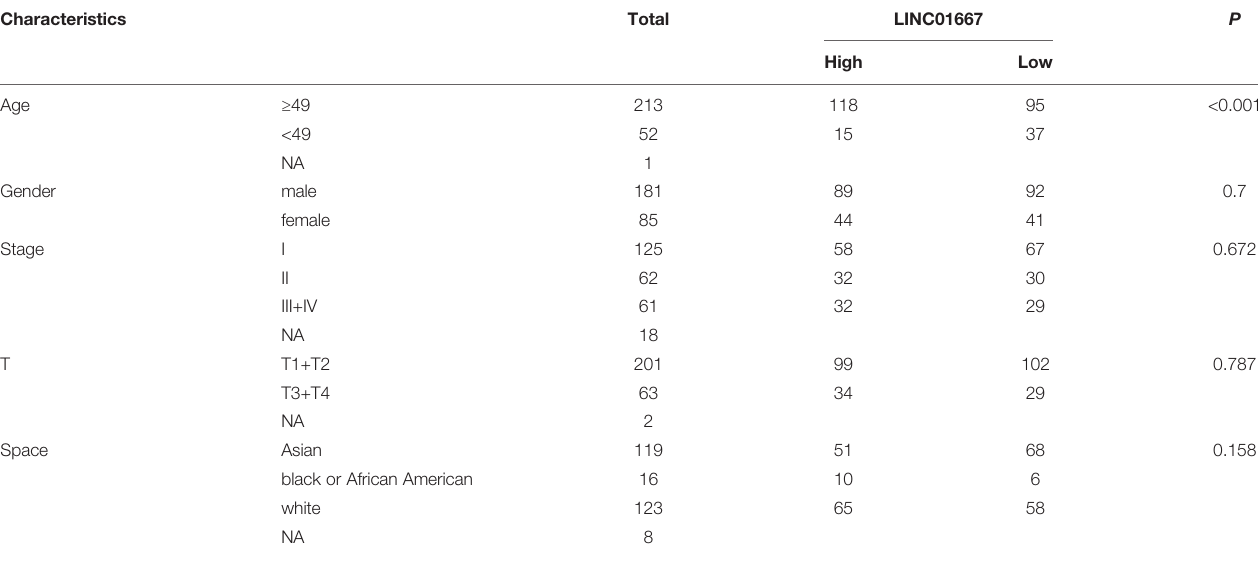
TABLE 1 | Correlations between LINC01667 expression and clinicopathological characteristics in HCC.